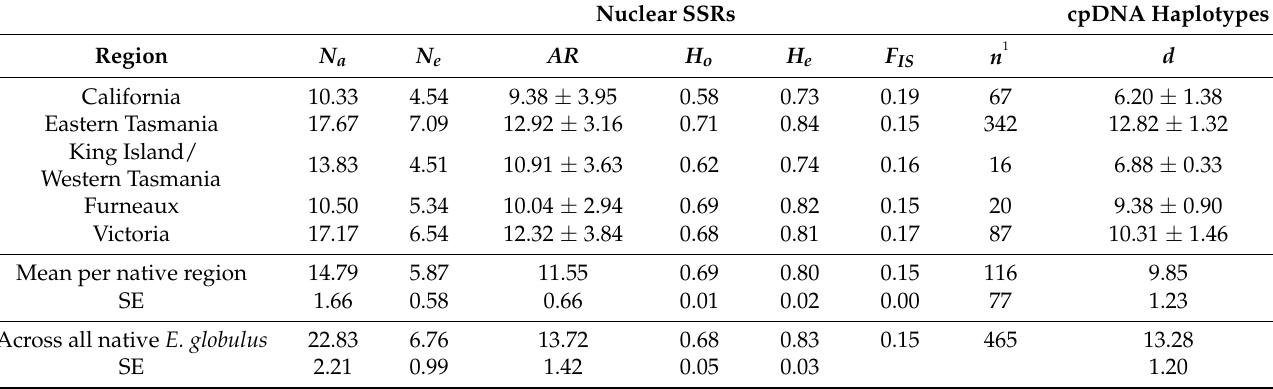
Table 3. Genetic diversity statistics for the Californian and Australian native stand samples of Eucalyptus globulus grouped into four regions. The samples used to represent the four regions of the Australian distribution were collected from across the native range of E. globulus and comprised 590 samples for SSR data and 465 for the chloroplast J LA+ (see Methods for